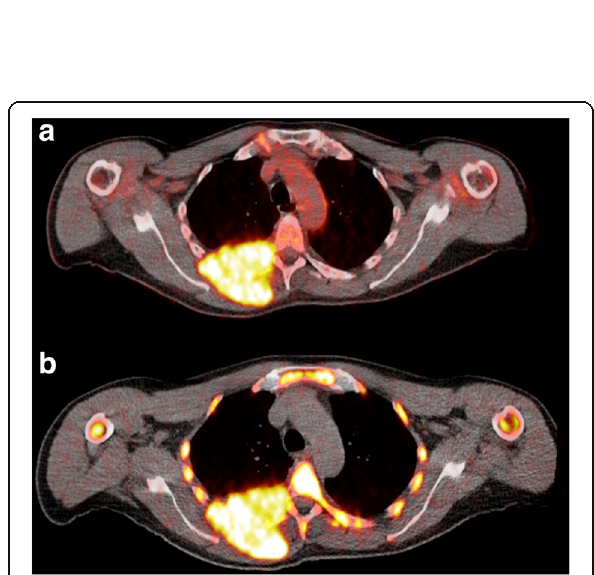
Fig. 4 Transaxial 18 F-FDG PET/CT ( a ) and 18 F-FLT PET/CT ( b ) images at the thoracic level of a 60-year-old male patient with symptomatic MM. Myeloma lesion of the seventh rib with extramedullary tumor expansion to the surrounding soft tissues and thoracic vertebra after disrupting the cortical bone. The lesion shows increased accumulation in both 18 F-FDG and 18 F-FLT PET/CT imaging